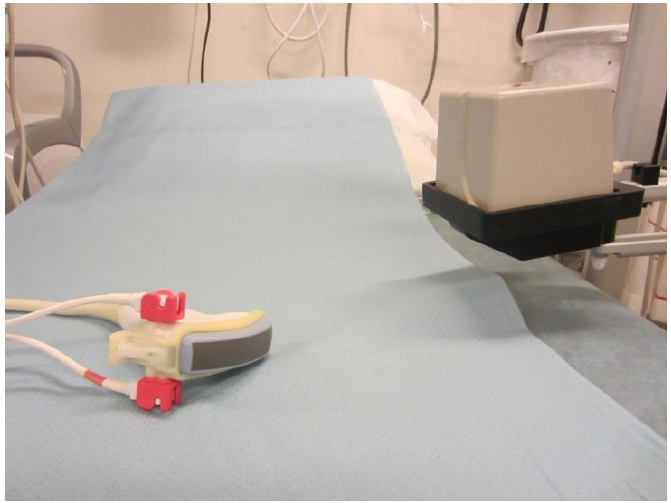
Figure 2. Magnetic positioning system. Magnetic sensors attached to the transducer ( left ) and magnetic transmitter ( right